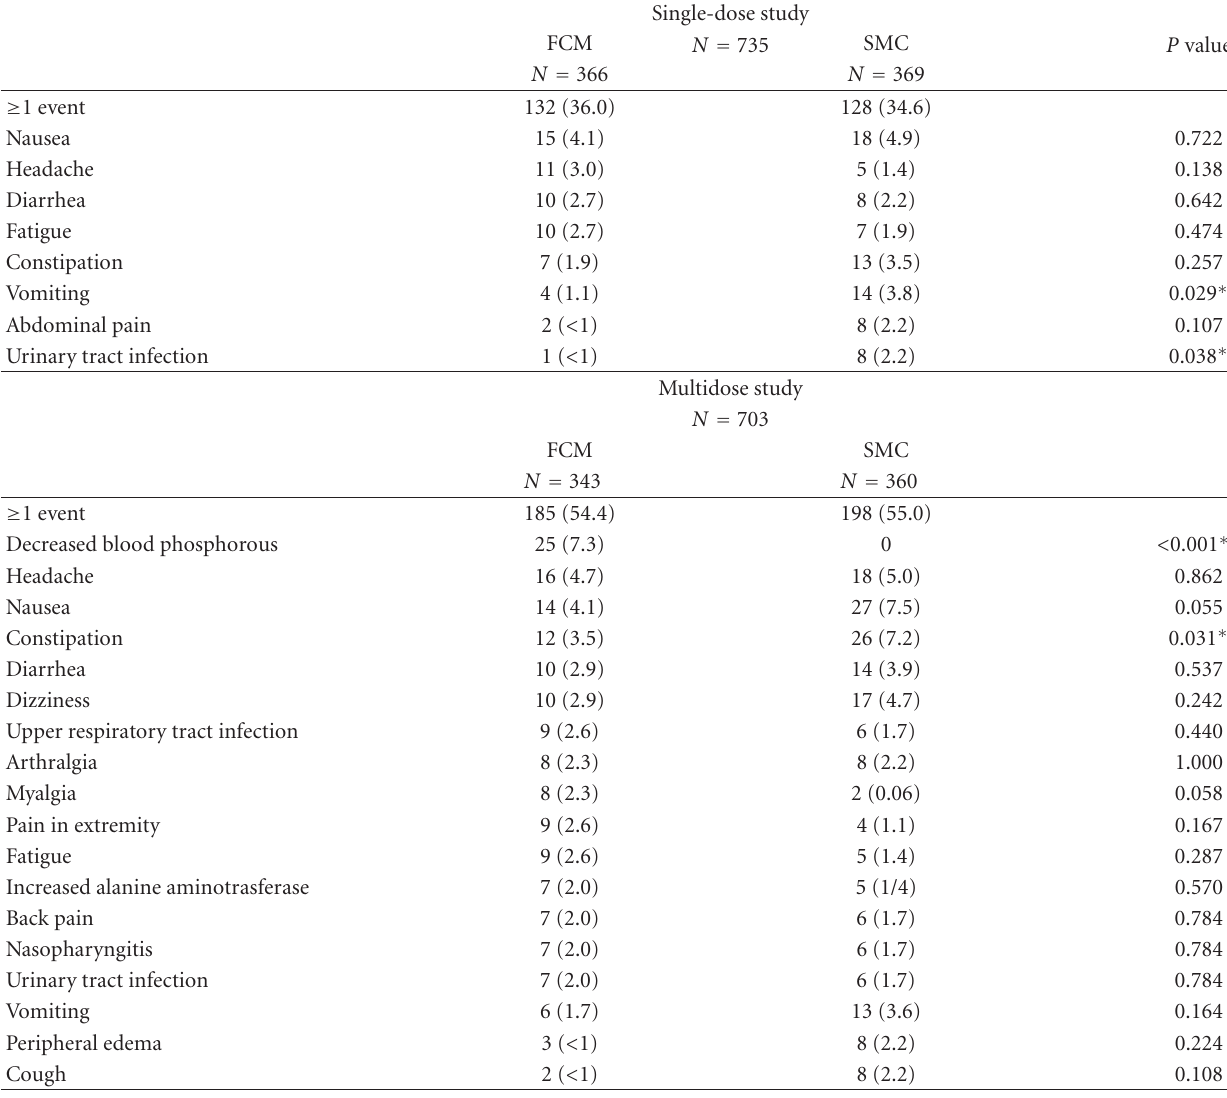
Table 2: Incidence of treatment-emergent adverse events occurring in ≥ 2% of